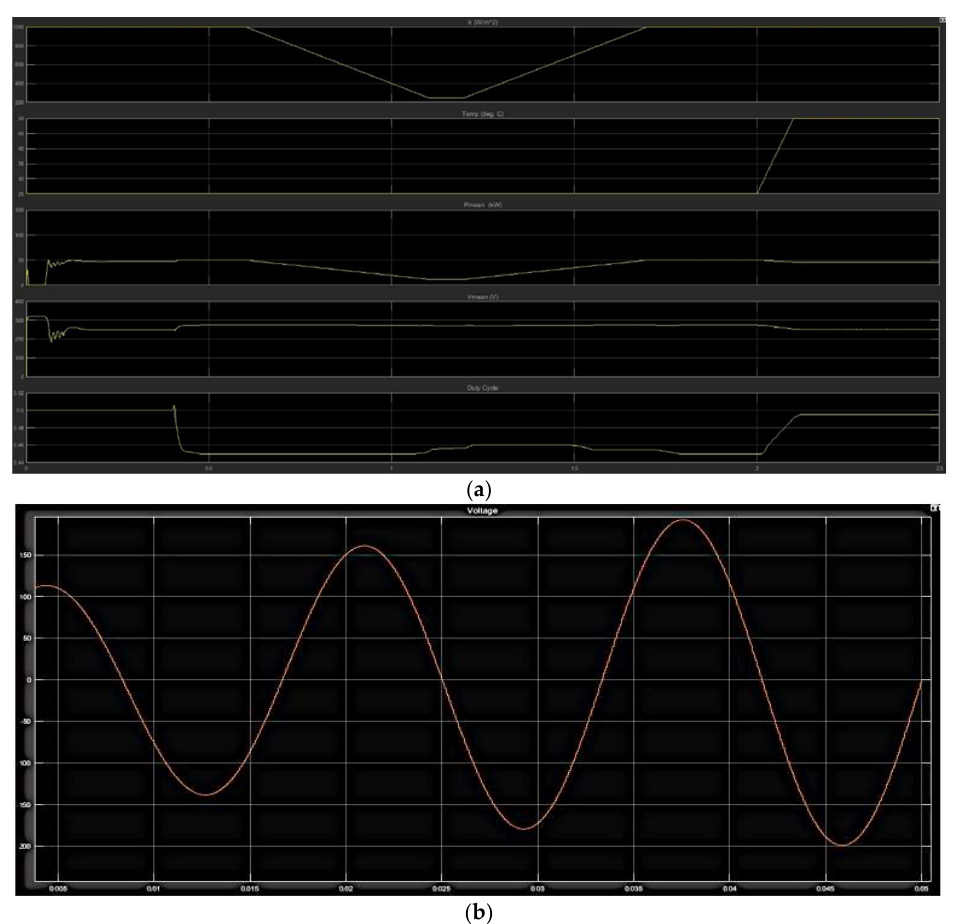
Figure 10. ( a ) AC power and voltage output of microgrid; ( b ) battery cycle of the storage in microgrid.